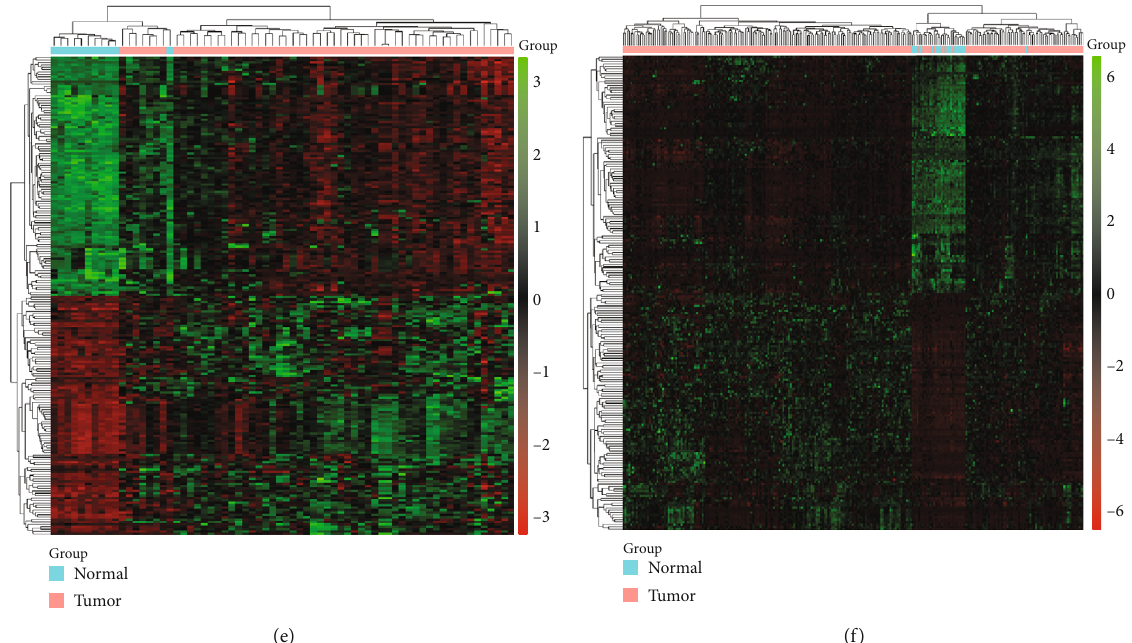
Figure 2: DEGs in three data sets. (a – c) The volcano plots visualize the DEGs in GSE116959, GSE21933, and GSE31210, respectively. The red nodes represent upregulated genes while the blue nodes represent downregulated genes. (d – f) Heatmap of the top 100 DEGs according to the value of ∣ logFC ∣ >1 and P < 0 : 01 . The green color indicates lower expression and red color indicates high